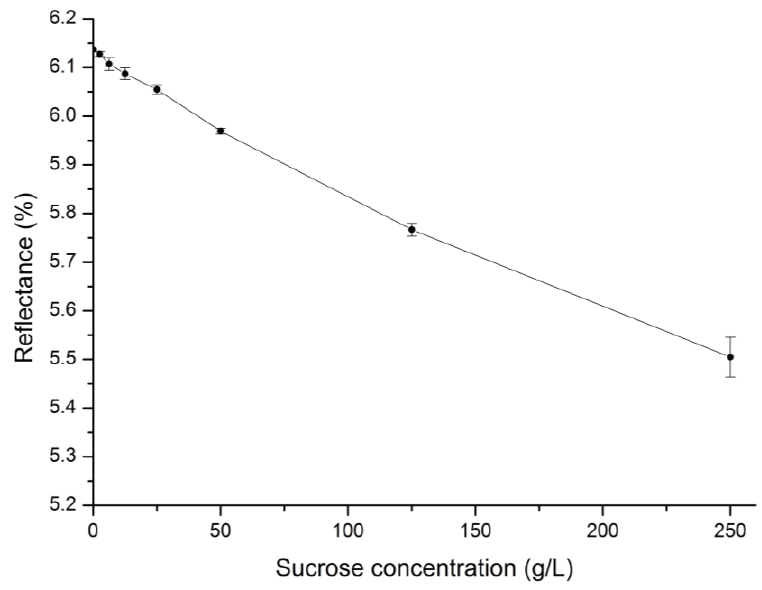
Figure 8. Evolution of the reflectance of the butterfly wing replica when covered by a sucrose solution of increasing concentration. The reflectance was measured at 600